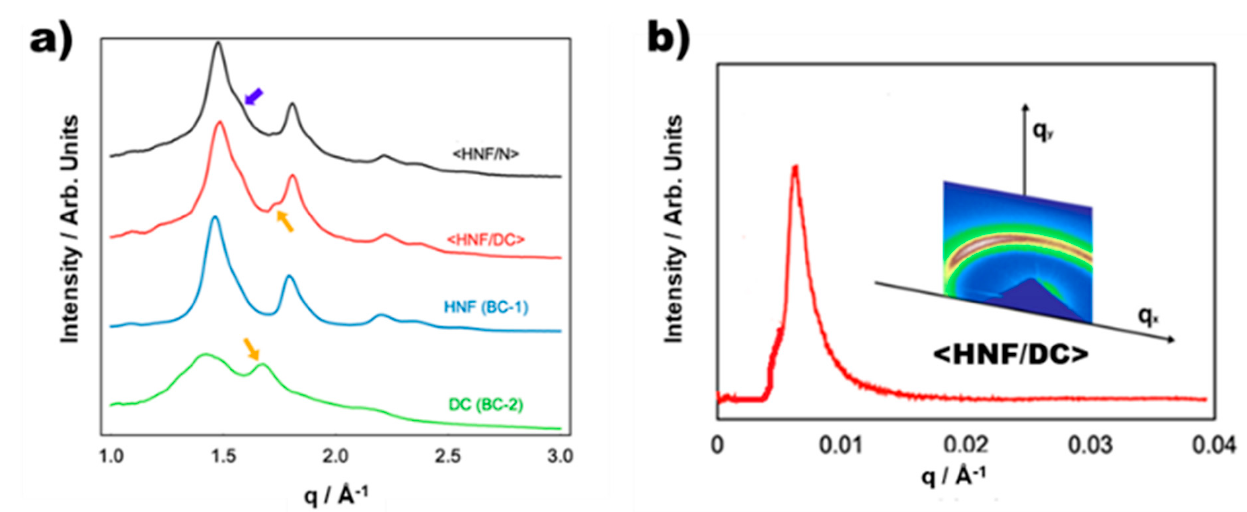
Figure 4. ( a ) Typical WAXD profiles generated in different temperature ranges for <HNF/N>, <HNF/DC>, pure HNF formed by BC-1, and pure DC formed by BC-2. ( b ) The 2D RSoXS pattern of <HNF/DC> at 90 °C and its 1D profile plotted on q . The triangular object in the leftmost part of the pattern is the dumper blocking the direct beam.